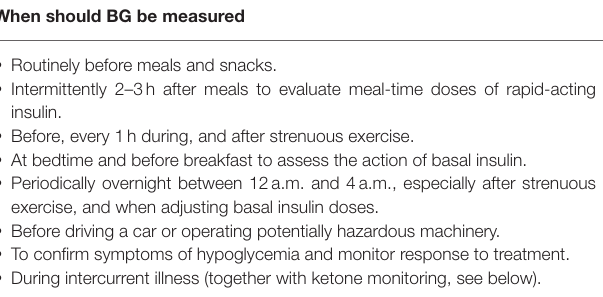
TABLE 2 | Recommendations for blood glucose